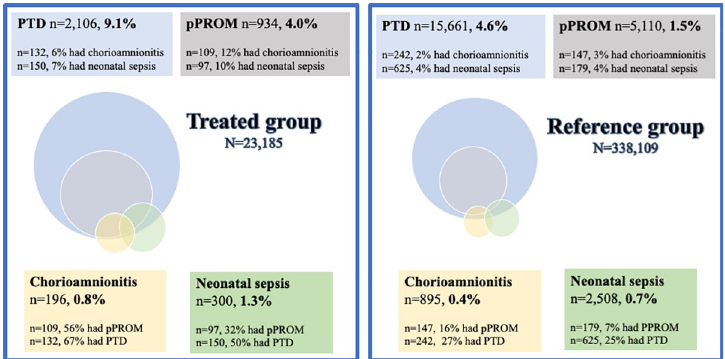
Fig 4. Venn diagram illustrating the relationship between preterm delivery (PTD), preterm prelabor rupture of membranes (pPROM), and infectious complications in the treated group and the reference group. The treated group had PTD, pPROM, and infectious complications more frequently. PTD and deliveries after pPROM were more often complicated by infections in the treated group than in the reference group. The deliveries with infectious complications were more frequently preterm and complicated by pPROM in the treated group than in the reference group.